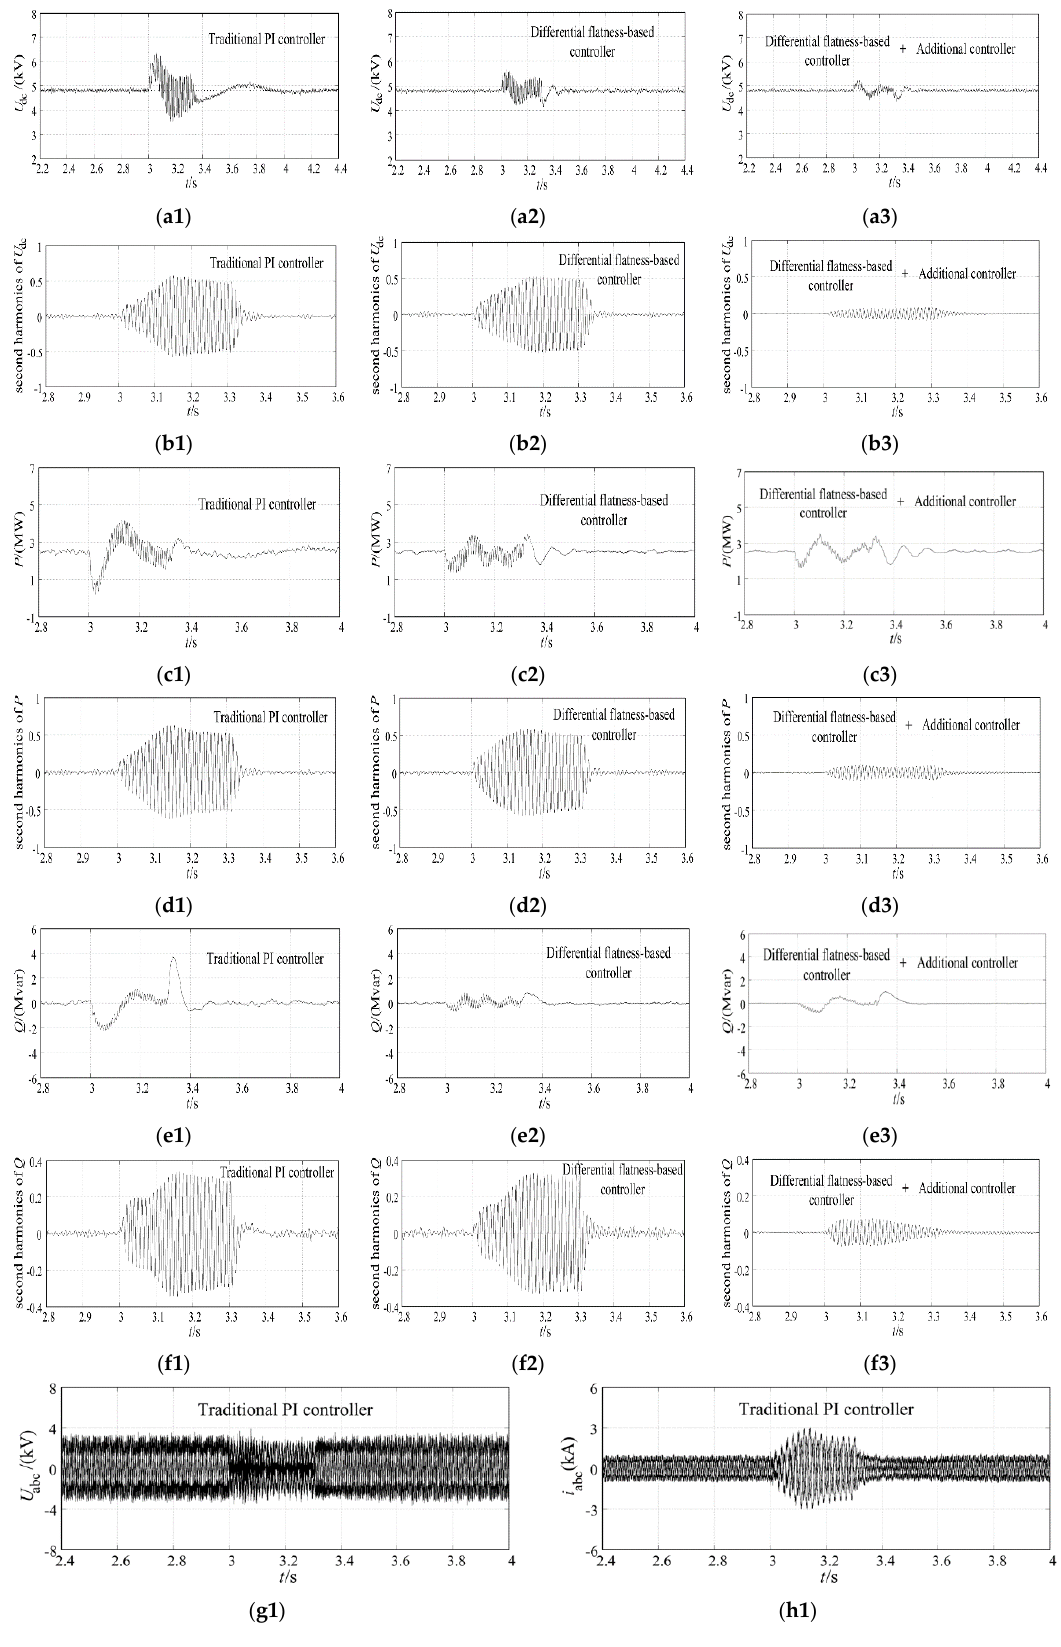
Figure 9. Cont. Figure 9.